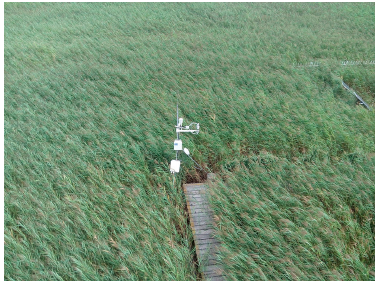
Figure 2. EC observation system.